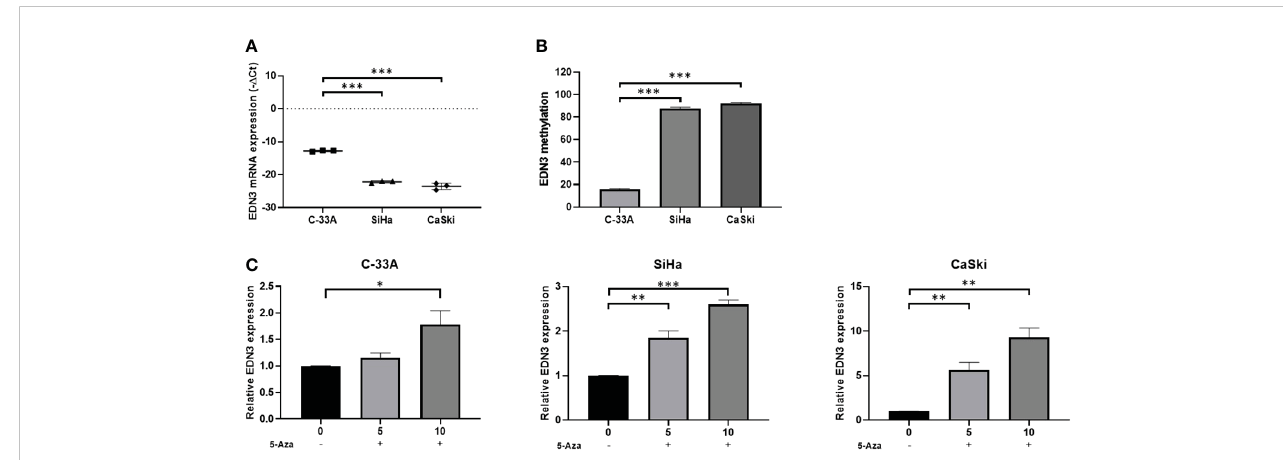
FIGURE 2 EDN3 expression in cervical cancer cells treated with 5-Aza. (A) Expression levels of EDN3 in C-33A, SiHa and CaSki cells. (B) Methylation levels (average percentage of methylation across 4 CpG sites) of EDN3 in C-33A, SiHa and CaSki cells. (C) The mRNA expression of EDN3 in C-33A, SiHa and CaSki cells before and after treatment with 5 and 10 m M 5-Aza. Values are mean ± SD, N = 3; *P<0.05; **P<0.01;